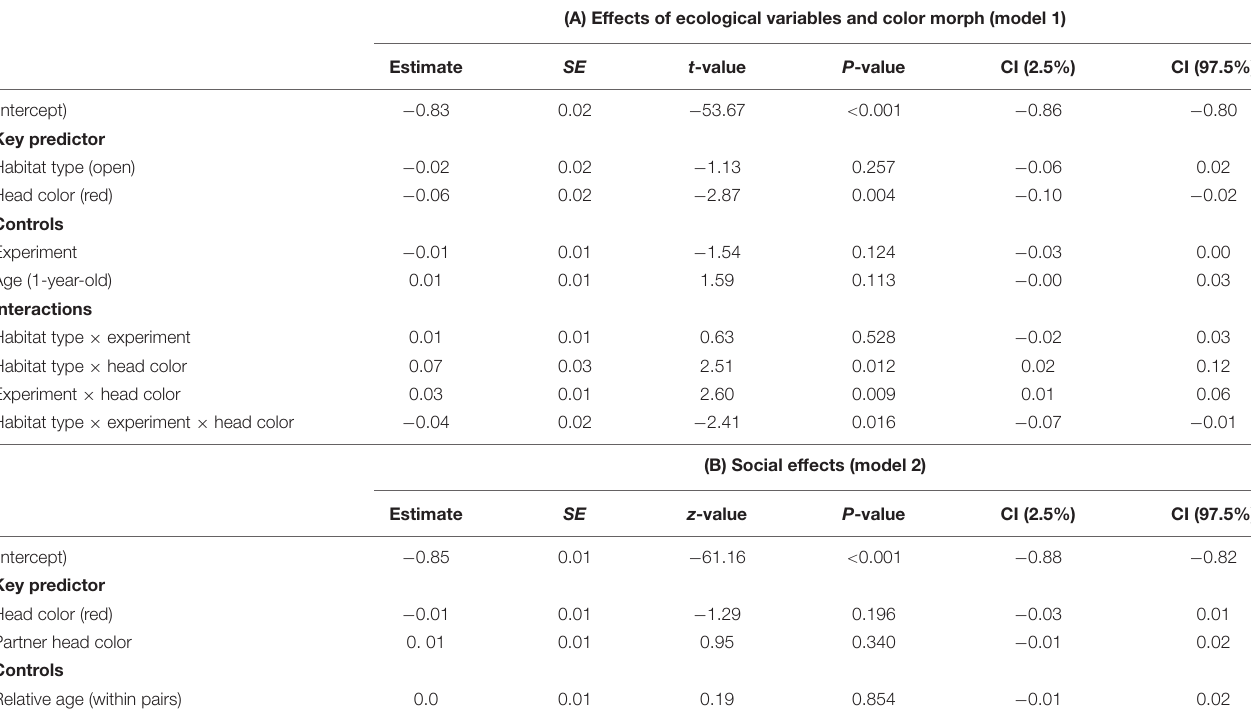
FIGURE 2 | Effects of head color and experiment on number of approaches before entering the novel habitats. In experiment 1, same sex pairs of either same or different head color were tested on their response to enter an artificial open habitat (their preferred habitat type) and an artificial dense habitat. In experiment 2, birds were tested in the opposite head color composition with a new open and dense habitat. Mean and SE of number of approaches to novel habitats in the first and second experiment for each head color. * P < 0.05. Black bars: black-headed birds (BH), striped red and gray bars: red-headed birds (RH). TABLE 2 | Results of the linear mixed effects models on the entry latencies of Gouldian finches into open and dense habitats addressing (A) the relationship between ecological variables and color morph and (B) social effects. (A) Effects of ecological variables and color morph (model